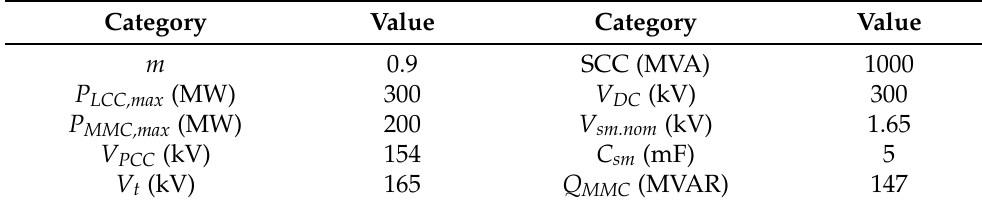
Table 2. Parameter estimation for Jeju HVDC No. 3.